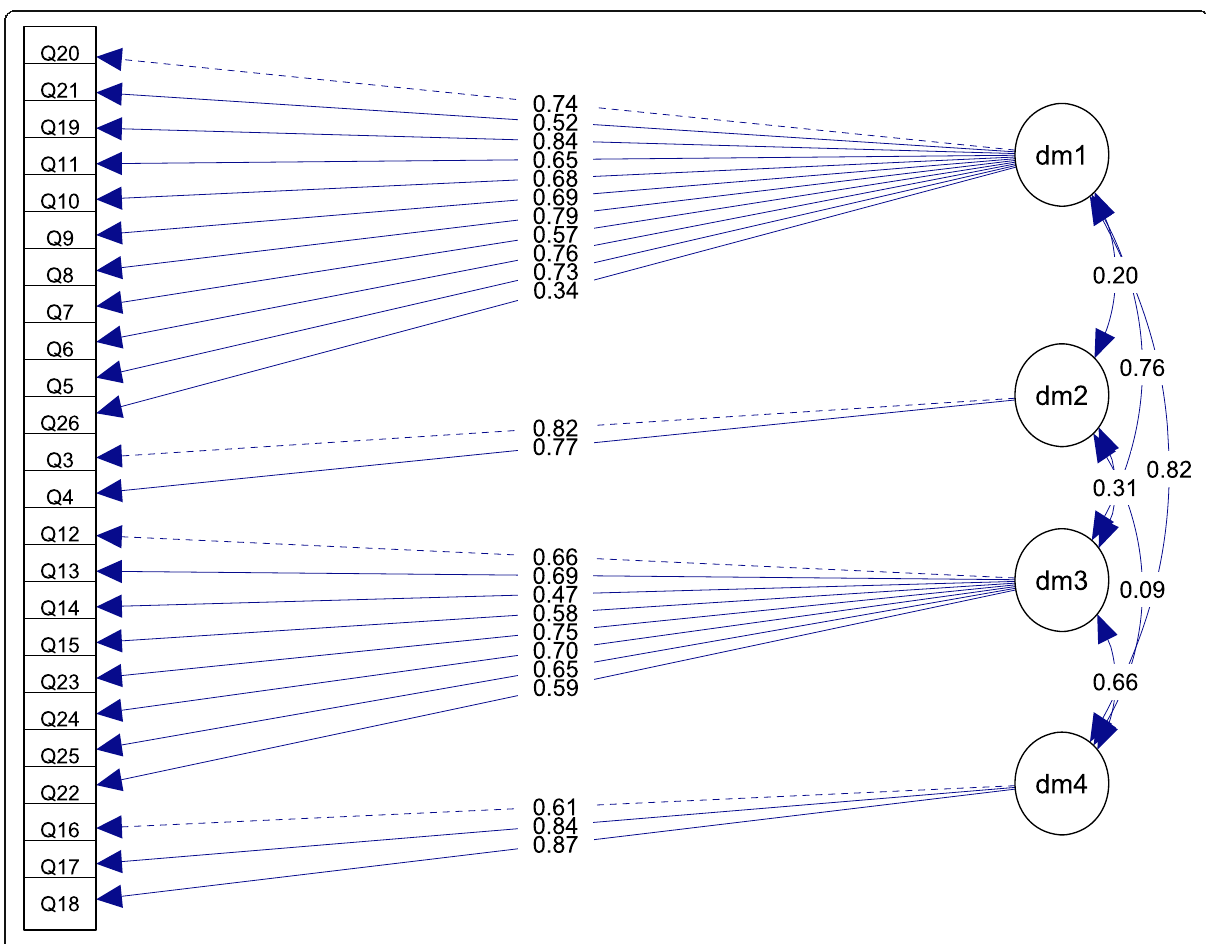
Fig. 3 Factor loadings obtained by confirmatory factor analysis